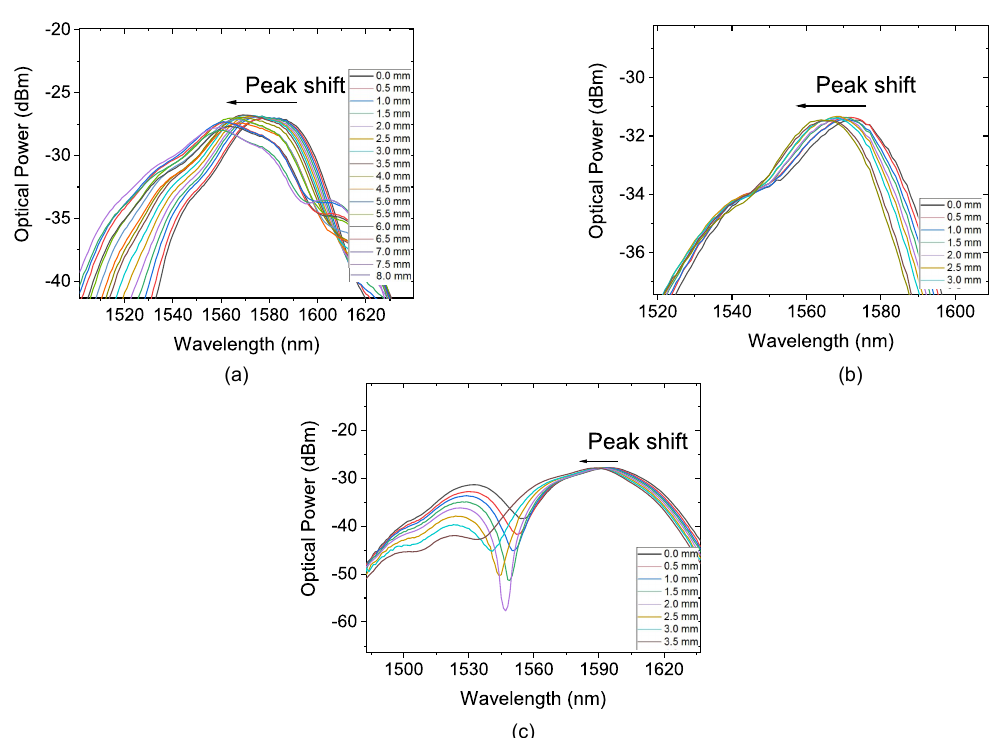
Figure 10. Transmission spectrum of the sensor submitted to diameter variation with D S = 110 mm.